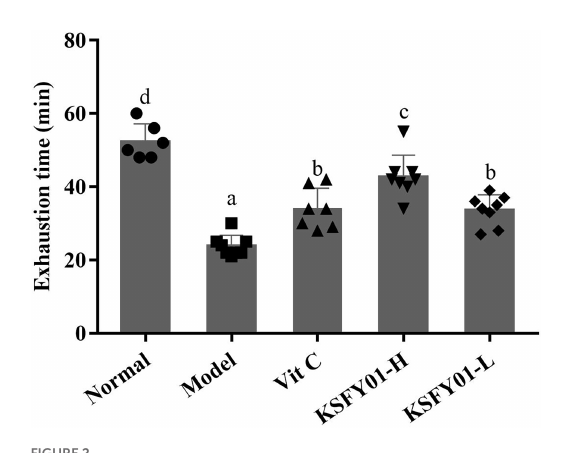
FIGURE 2 Running exhaustion time of mouse in each group. a–d Values in the same column with different letter superscripts indicate significant difference ( p < 0.05). Vit C, mice treated with vitamin C (200 mg/kg); KSFY01-H, mice treated with L. plantarum KSFY01 (1 × 10 10 CFU/kg); KSFY01-L, mice treated with L. plantarum KSFY01 (1 × 10 9 CFU/kg).